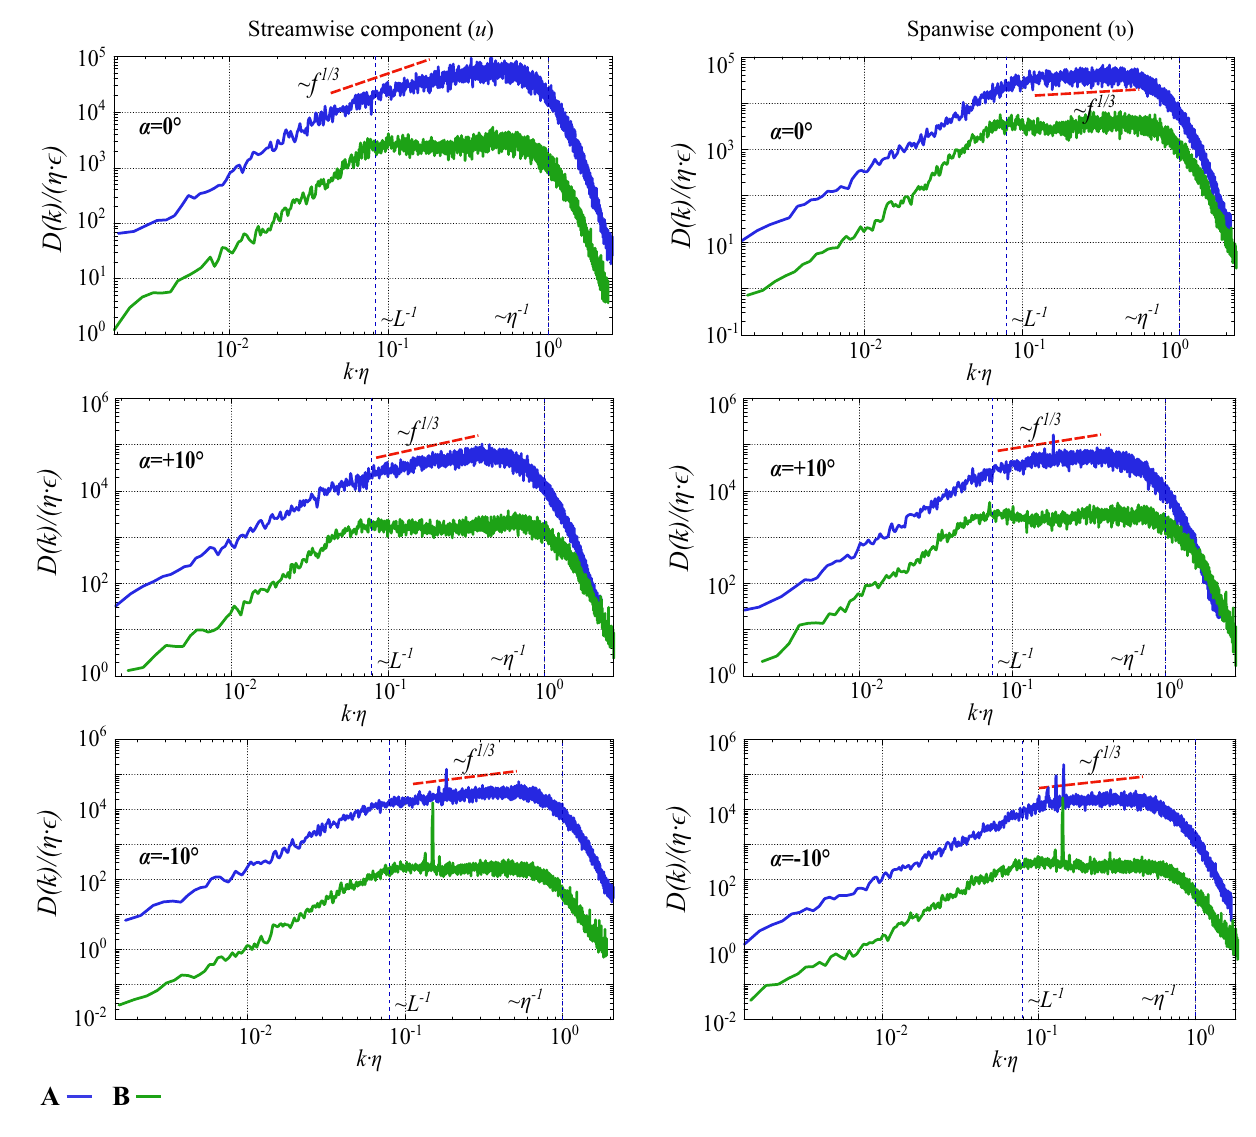
Fig. 9 Normalized dissipation spectral of straemwise and spanwise fluctuations depending on the angle of attack at x ⋅ c − 1 ≈ 0.2 and Re ≈ 1.7 × 10 5 . Green and blue color indicates the spectral density for measuring points A and B,